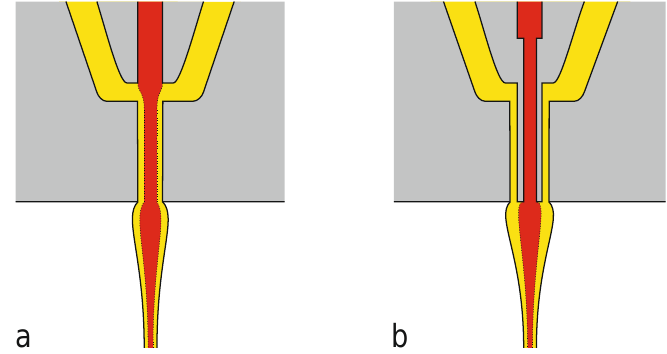
Figure 11. Two schematic examples of core-sheath bicomponent spinnerets: ( a ) single die and ( b ) multiple die. By way of illustration, the core and sheath polymer melts are represented in red and yellow, respectively.